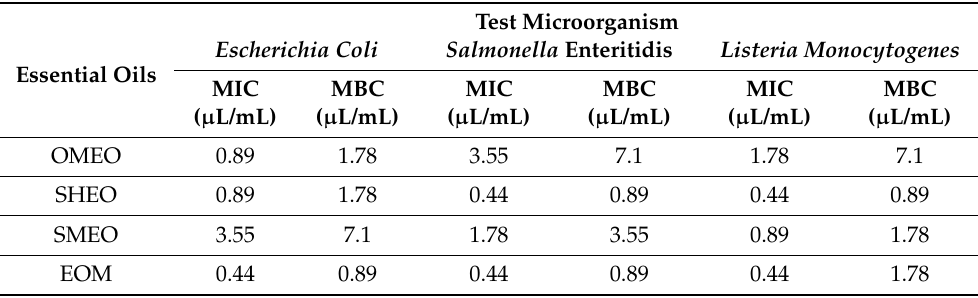
Table 2. Minimal inhibitory concentration (MIC) and minimal bactericidal concentration (MBC) of the selected essential